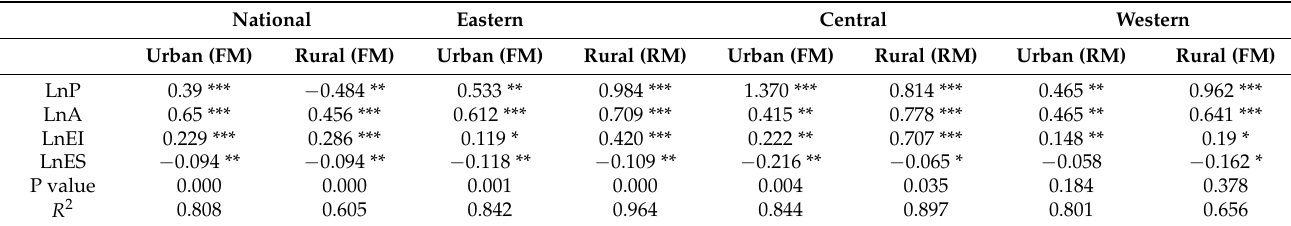
Table 5. Determinants of RCE in urban and rural regions of China during